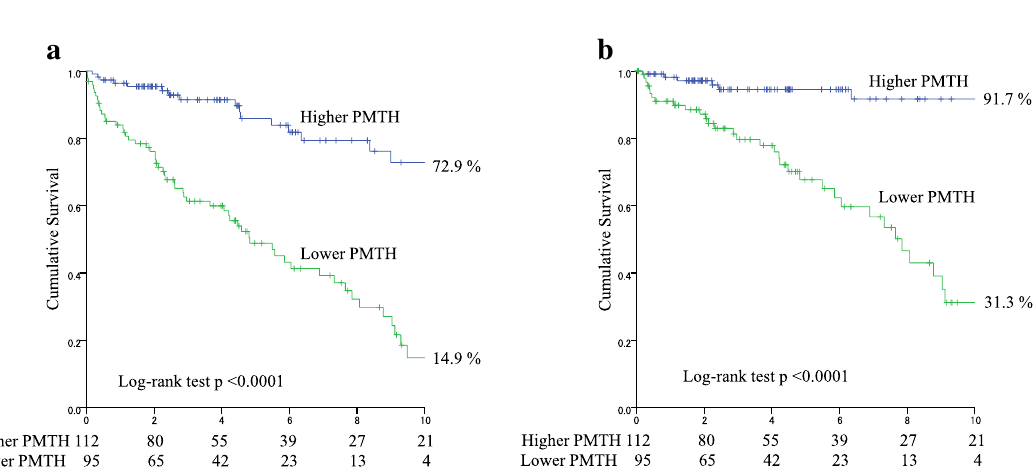
Figure 1. Kaplan–Meier survival curves. The all-cause mortality (a) and cardiovascular mortality (b) between the low PMTH and high PMTH groups were compared. PMTH psoas muscle thickness per